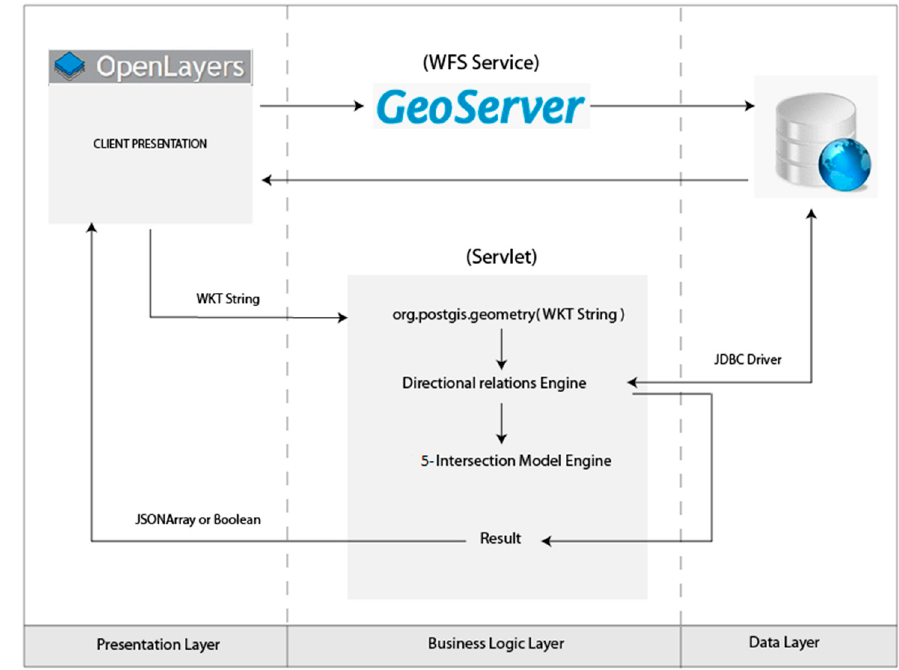
Figure 10. Architecture of the application framework.